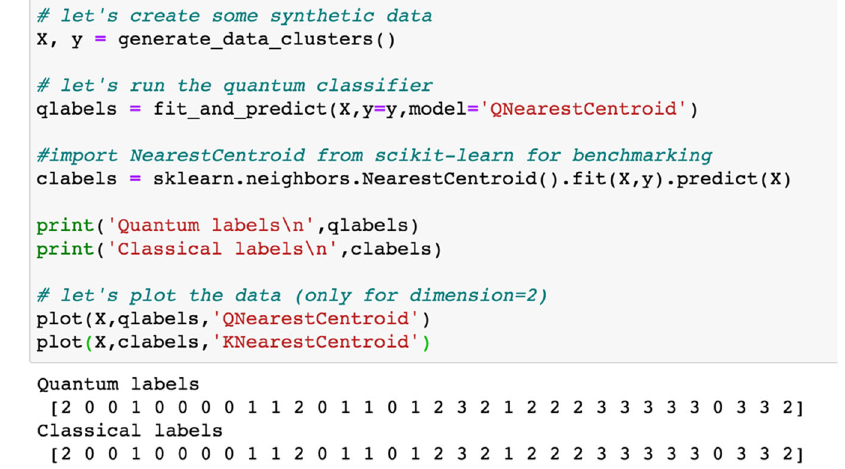
Fig. 7 Code. An example of a jupyter notebook that runs the Quantum Nearest Centroid algorithm, as well as the scikit-learn Nearest Centroid algorithm, and prints and plots the